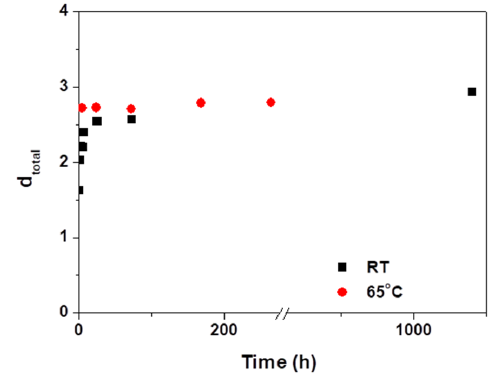
Figure 7. Evolution of total dimensionality for polysiloxane hybrids synthesized from the [TMOS]/[MPTS] mixture at room temperature (RT) and 65 °C for different times.